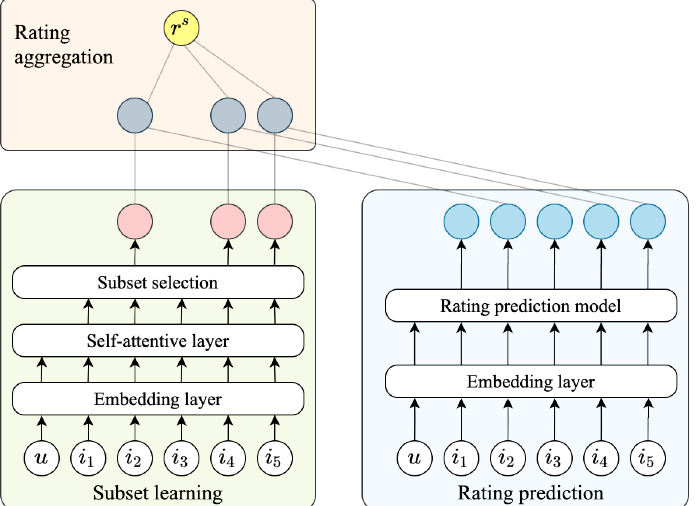
Figure 2. Model overview of the SaSLM, which consists of three components: rating prediction, subset learning, and rating aggregation. The rating prediction module predicts item-level ratings by matrix factorizing score function. The subset learning module is the key of the proposed model, which outputs a representative subset in an end-to-end manner. The rating aggregation module predicts users’ set-level ratings according to the item-rating predictions and subset selection results from two other modules. Finally, the model is optimized under the supervision of set ratings that users